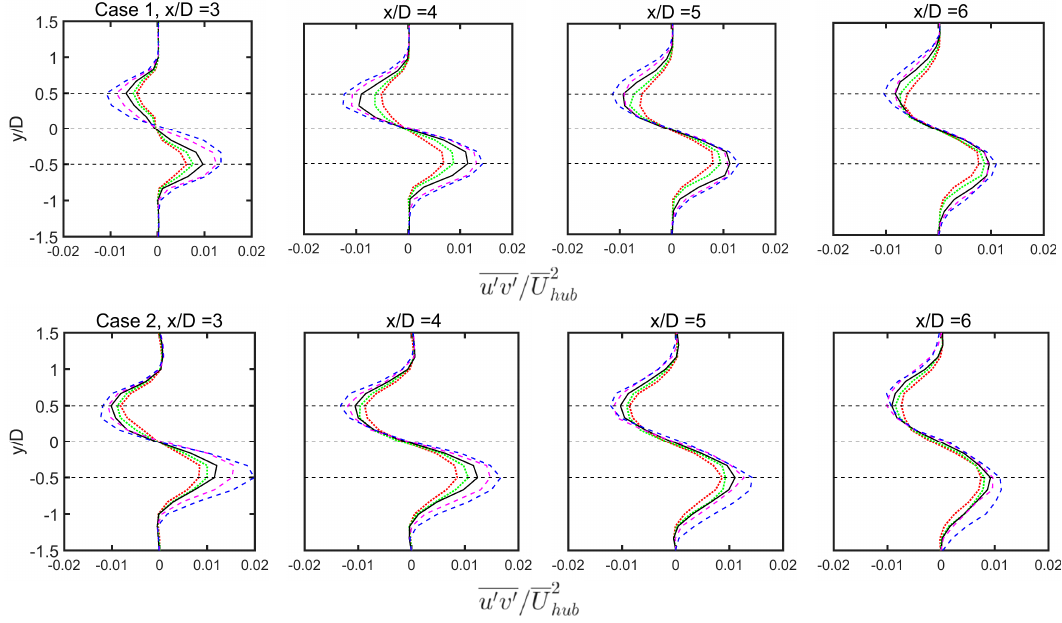
Figure 7. Spanwise profiles of normalized lateral momentum flux at a plane through the turbine hub, for a turbulence intensity of 4.3% ( top ) and 6.3% ( bottom ) for the incoming flow.